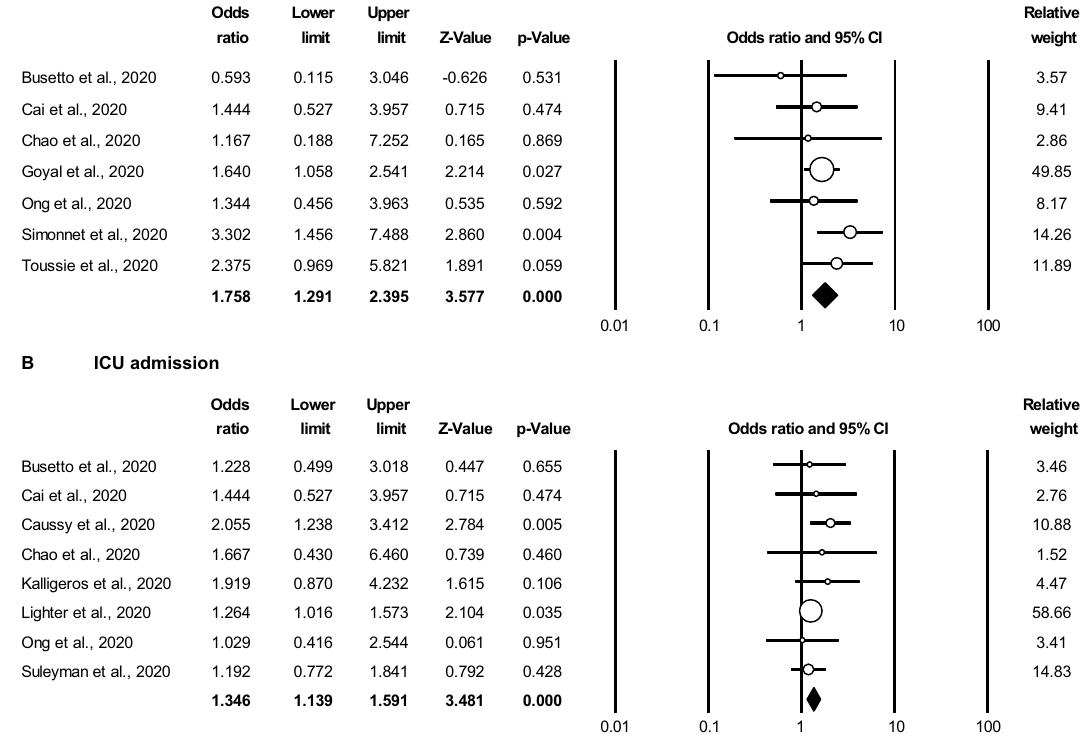
Figure 3. Obesity is associated with an increased likelihood of requiring invasive mechanical ventilation (IMV) and admission to the intensive care unit (ICU) in the setting of COVID-19. Random effects meta-analyses of odds ratios (OR) and 95% confidence intervals (CI) in obese versus non-obese patients for ( A ) requiring IMV (7 studies, n = 1,261) and ( B ) admission to an ICU (9 studies, n = 3227). Non-obese is defined as the reference